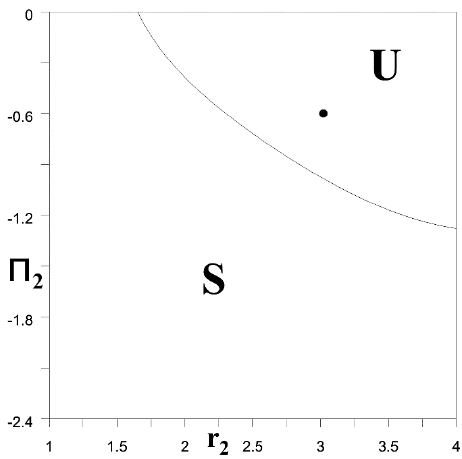
Figure 3. Neutral stability curve of the two-layer axisymmetric structure composed of the synoptic surface cyclonic vortex and the anticyclonic middle-layer lens for the mode m = 2 on the plane of variables ( r 2 ; Π 2 ) with r 1 = 4 and Π 1 = 0.25. The designations S and U correspond to stable and unstable regions. The round marker corresponds to the parameters used in the experiment shown in Figure 4.